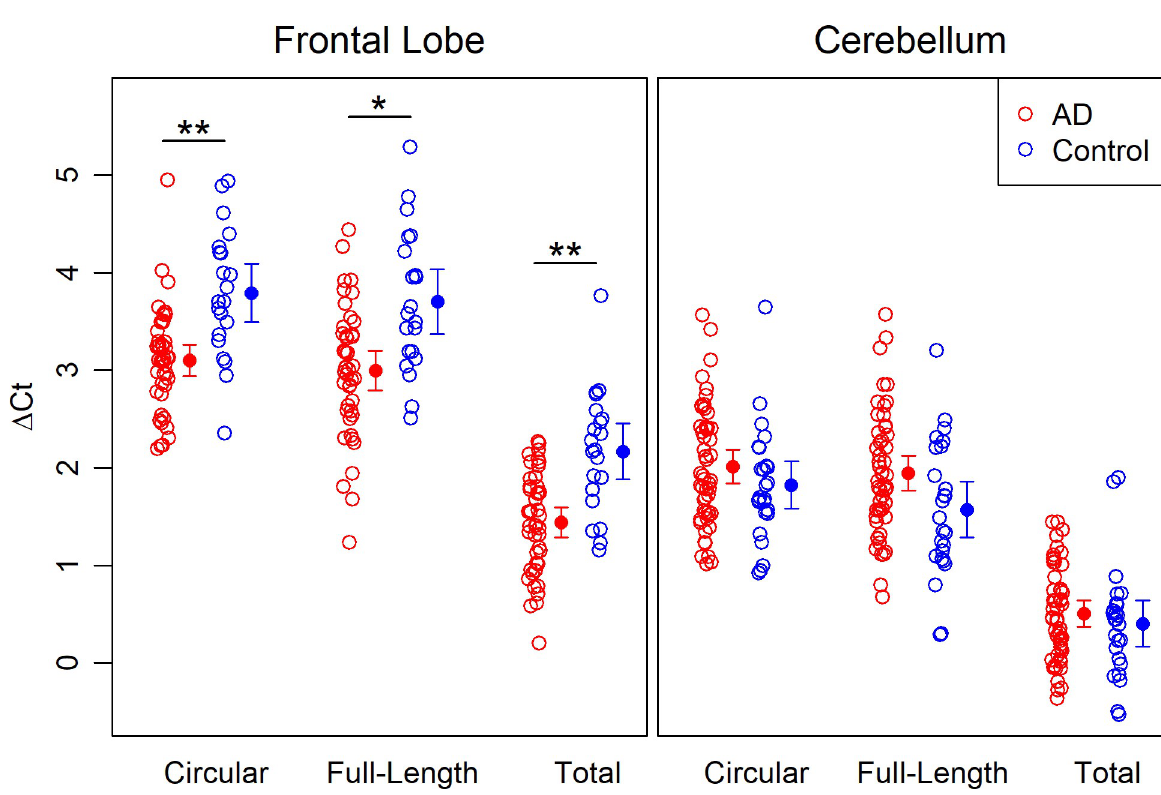
Fig 4. APOE RNA expression levels in human PMB tissues. Expression levels of three APOE RNAs (circular, full-length, and total) are plotted as values of Δ Ct (Ct of APOE RNA–Ct of ACTB RNA) and compared between AD (red) and control (blue) in both frontal lobe (left panel) and cerebellum (right panel). Filled circles with error bars represent mean with 95% CI. � : Holm-corrected p < 0.001; �� : Holm-corrected p < 0.0001. ACTB: β Actin; AD: Alzheimer’s disease; CI: confidence interval; Ct: cycle threshold; PMB: postmortem brain.